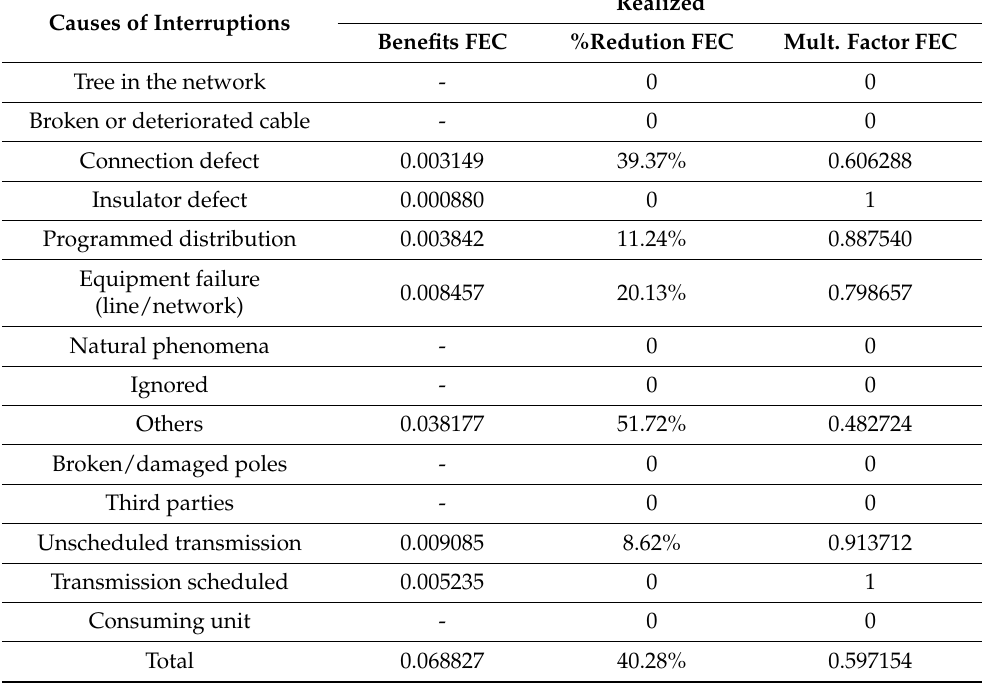
Table 3. Calculated benefits of